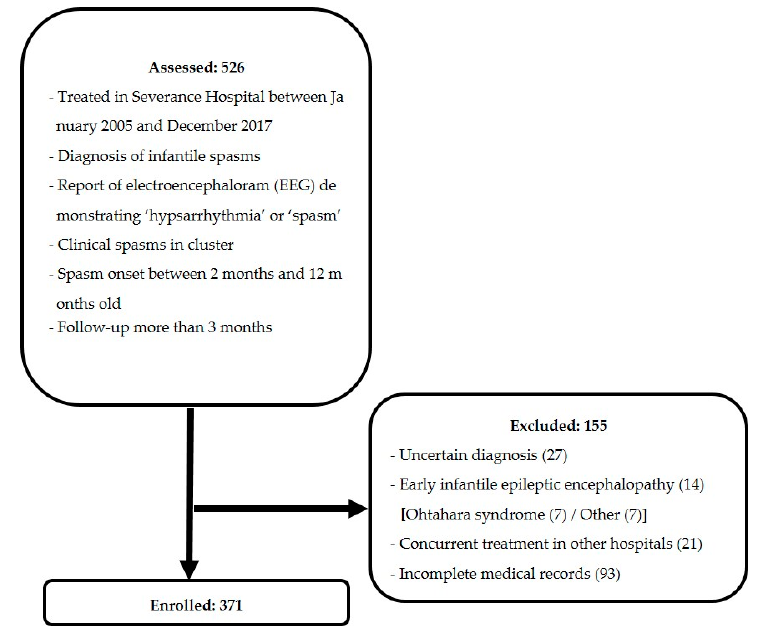
Figure 1. Flowchart of patient inclusion and exclusion criteria.